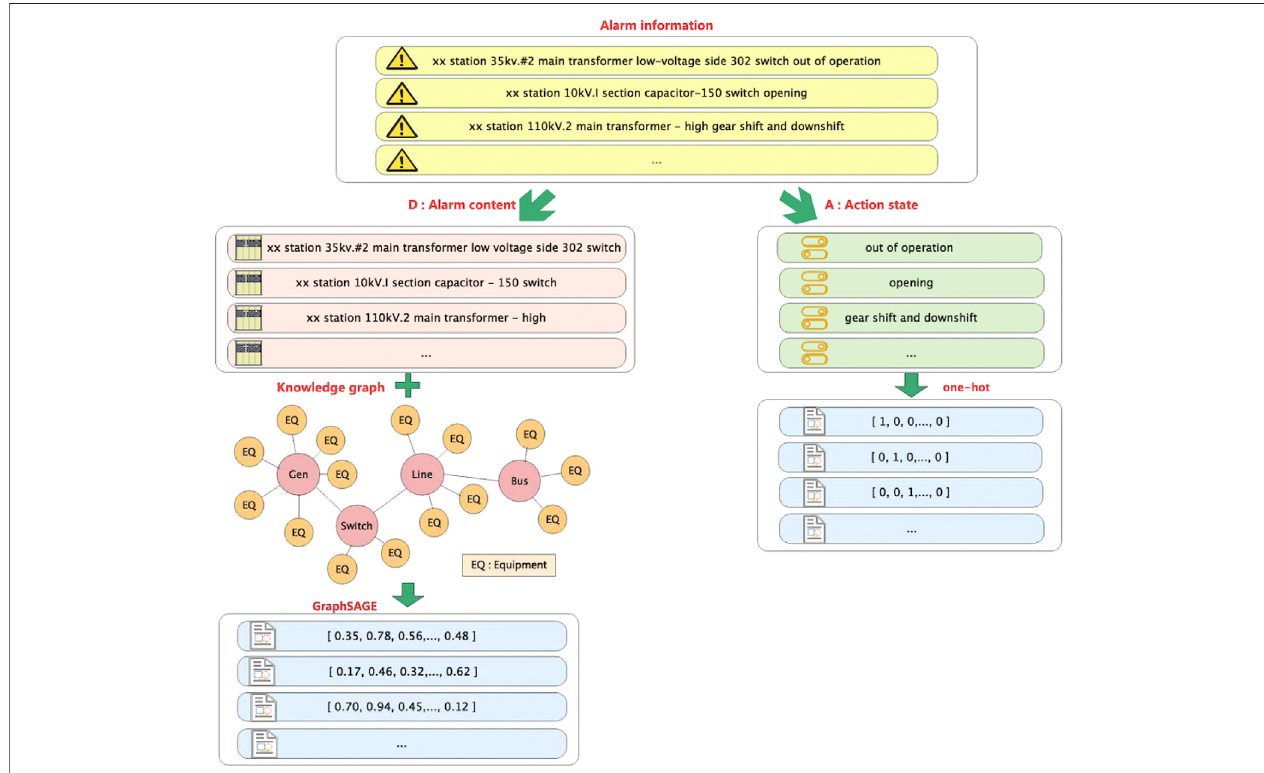
FIGURE 4 | Vectorization model of monitoring alarm information based on knowledge graph and GraphSAGE.